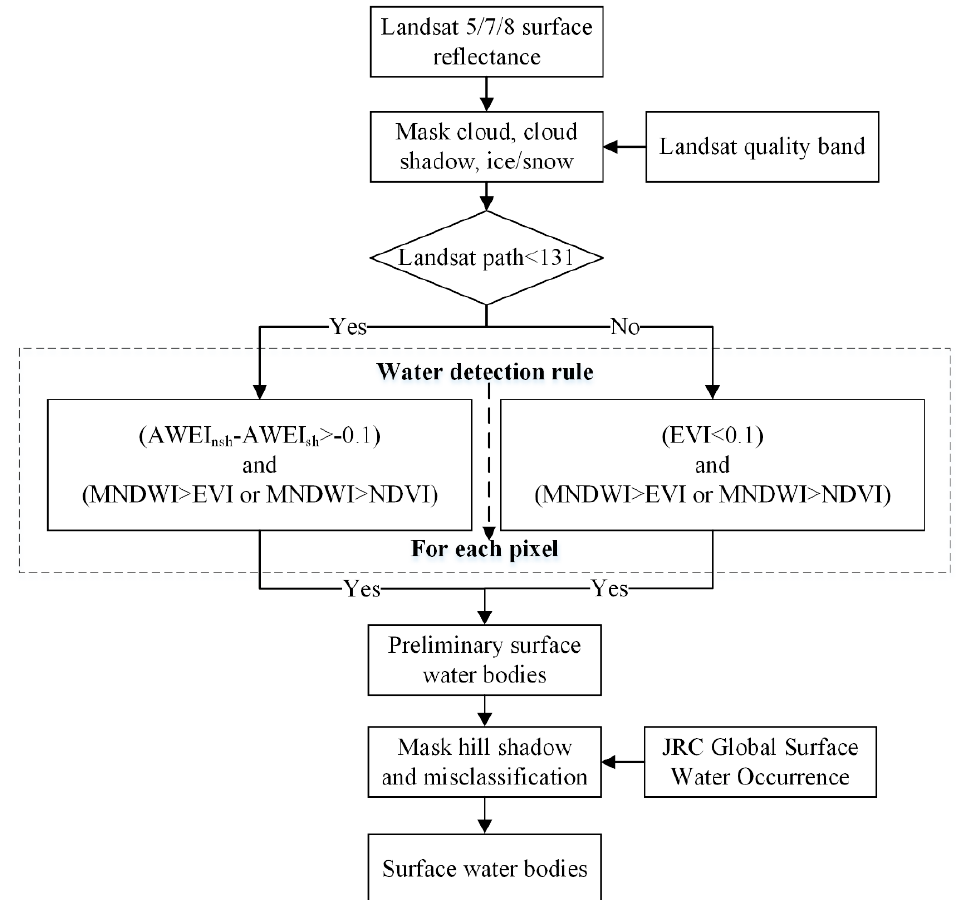
Figure 5. The flowchart of the extraction of surface water bodies in the Yangtze River Basin (YRB).